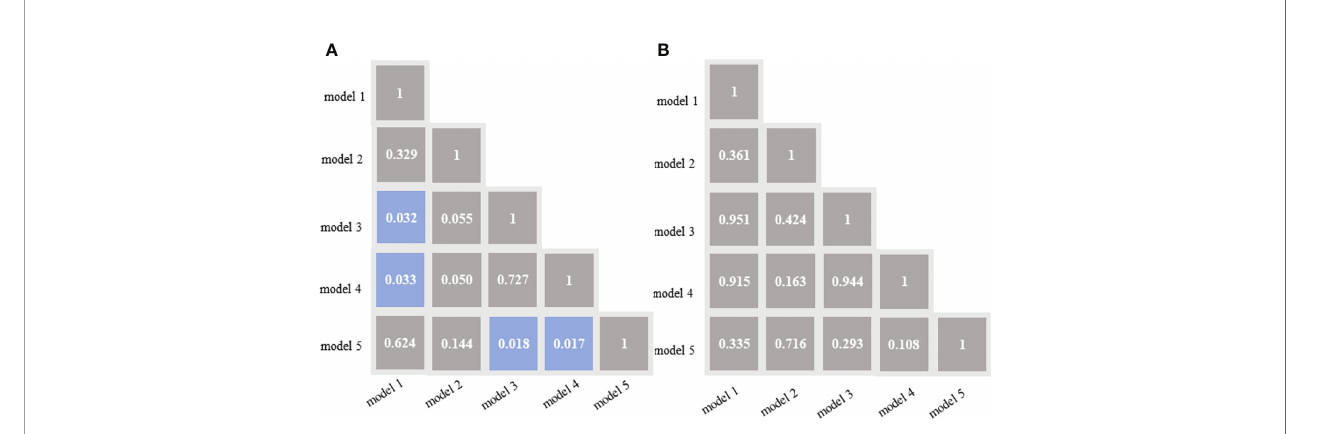
FIGURE 4 | DeLong test of the areas under the curve (AUCs) of the 5 models in the training cohort (A) and validation cohort (B) . Blue boxes represent p<0.05; Other grey boxes show p > 0.05. model 1 = radiomics model_IVC; model 2= radiomics model_TT; model 3 = combined model_IVC; model 4 = combined model_TT; model 5 = radiological model.